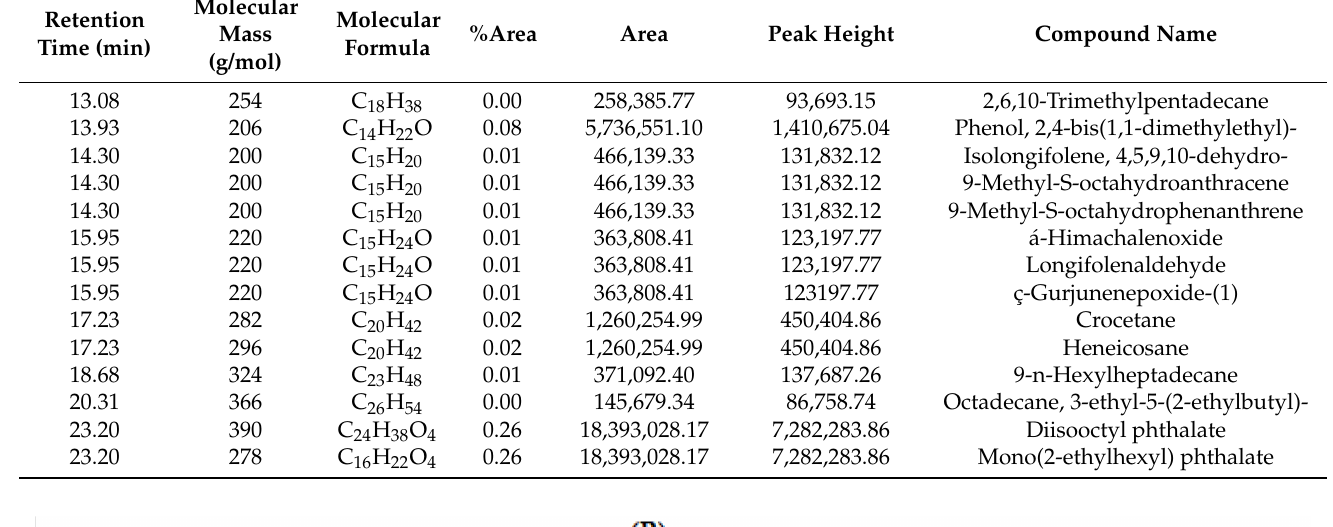
Table 3. Major phytochemical compounds identified in Indigofera linifolia and their various parameters.